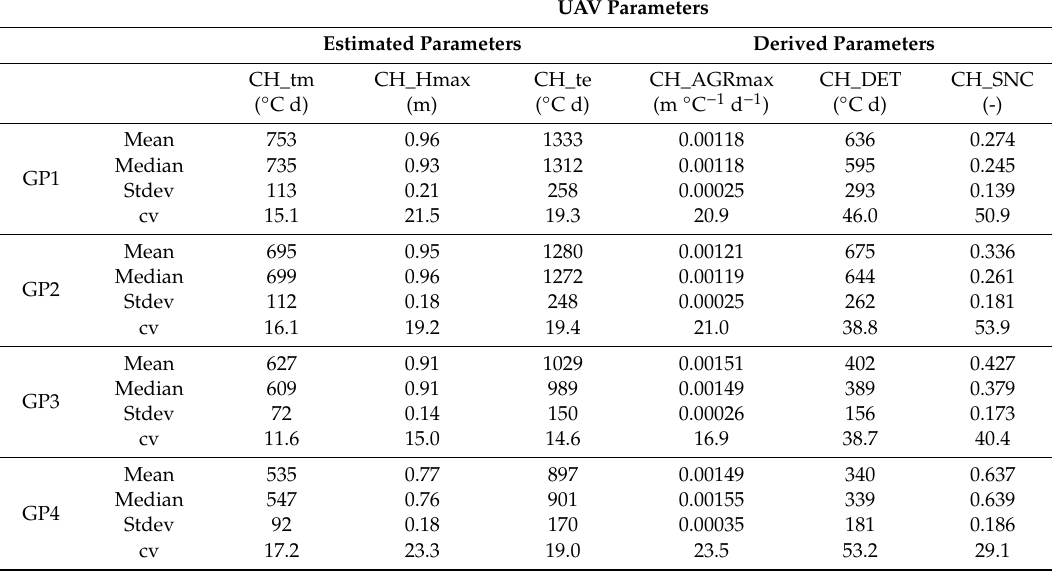
Figure 4. Boxplots of the phenotypic parameters ( a – f ) derived from the curve fitting of canopy cover data. The data is presented per group (GP 1–4) and all groups together (All). For abbreviations see For CH, the parameter values are presented in Table 3. For CH_tm ( from 547 to 735, for CH_Hmax (m) from 0.76 to 0.96 and for CH_te ( Table 3. Mean, median, standard deviation (Stdev) and coe ffi cient of variation (cv) of the phenotypic parameters derived from fitting the canopy height data. Data are presented per group (GP1-4). For the abbreviations, see Table